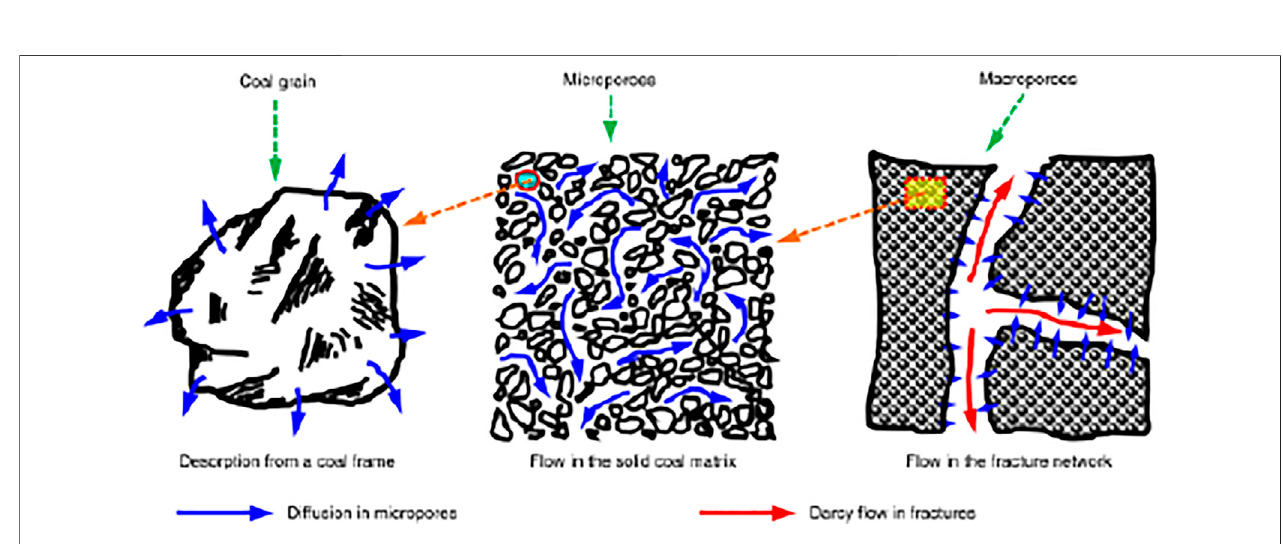
FIGURE 2 | Schematic diagram of micro fl ow mechanism of coalbed methane (Zhao et al., 2016).